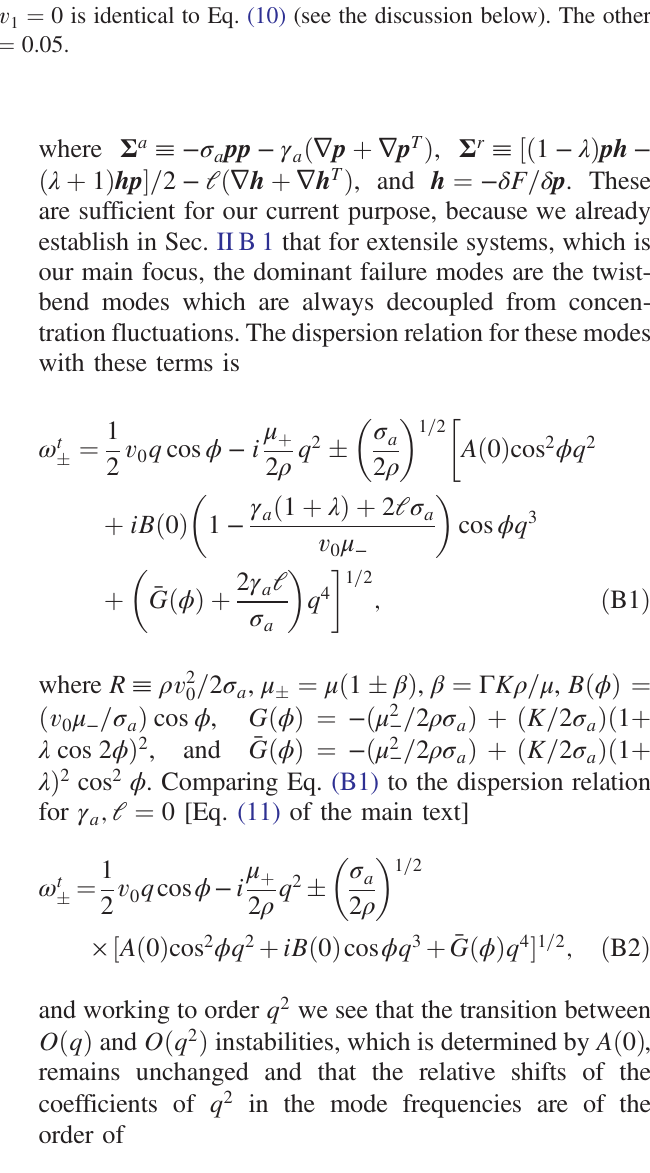
FIG. 9. Maximum growth rate of the unstable splay-bend modes for different values of v 0 and v 1 for (a) O ð q Þ ∶ R ¼ 0 . 1 and (b) O ð q 2 Þ ∶ R ¼ 5 regimes. Note that the dispersion relation for v 1 ¼ 0 is identical to Eq. (10) (see the discussion below). The